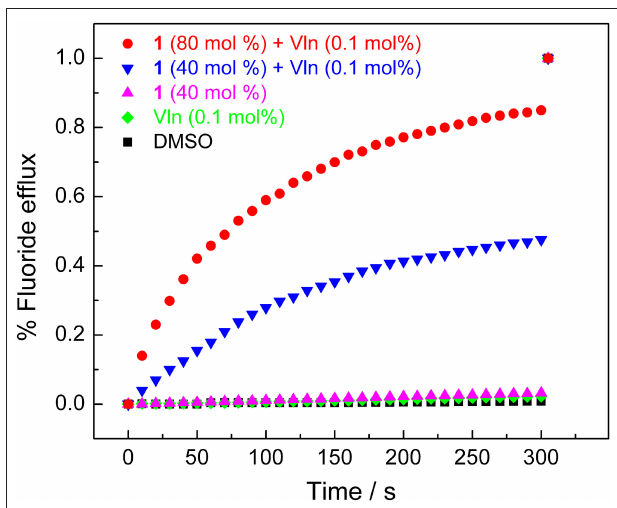
FIGURE 5 | ISE assay for fluoride efflux obtained by addition of compound 1 (40 and 80 mol%) in the presence and absence of Vln (0.1 mol%).